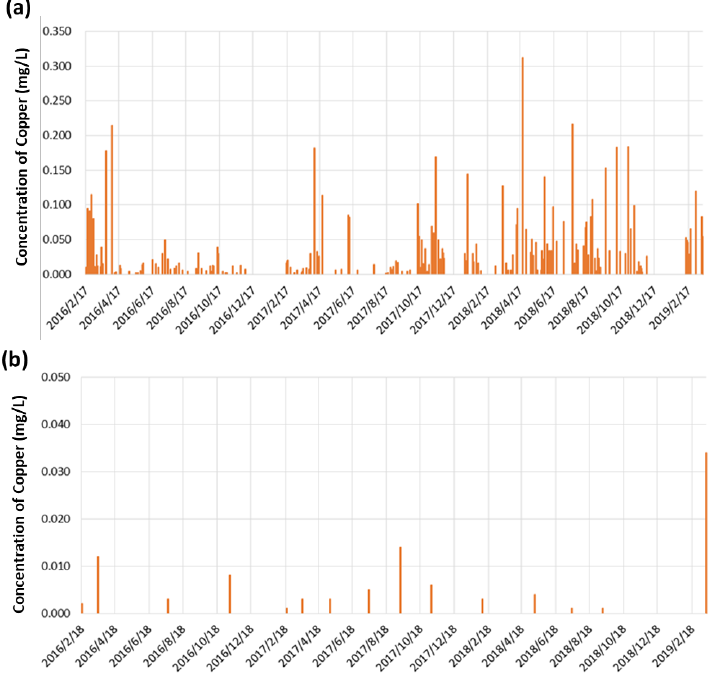
Figure 6. Comparison of ( a ) automatic sampling at Tieshan branch line, and ( b ) regularly manual sampling at Tieshan branch line for monitoring Cu concentration of irrigation water.